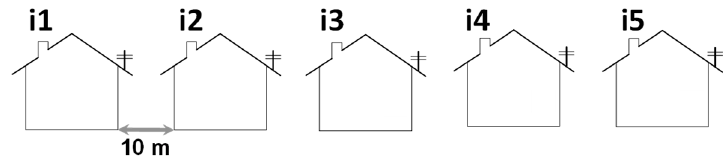
Figure 1. The five-house neighborhood.